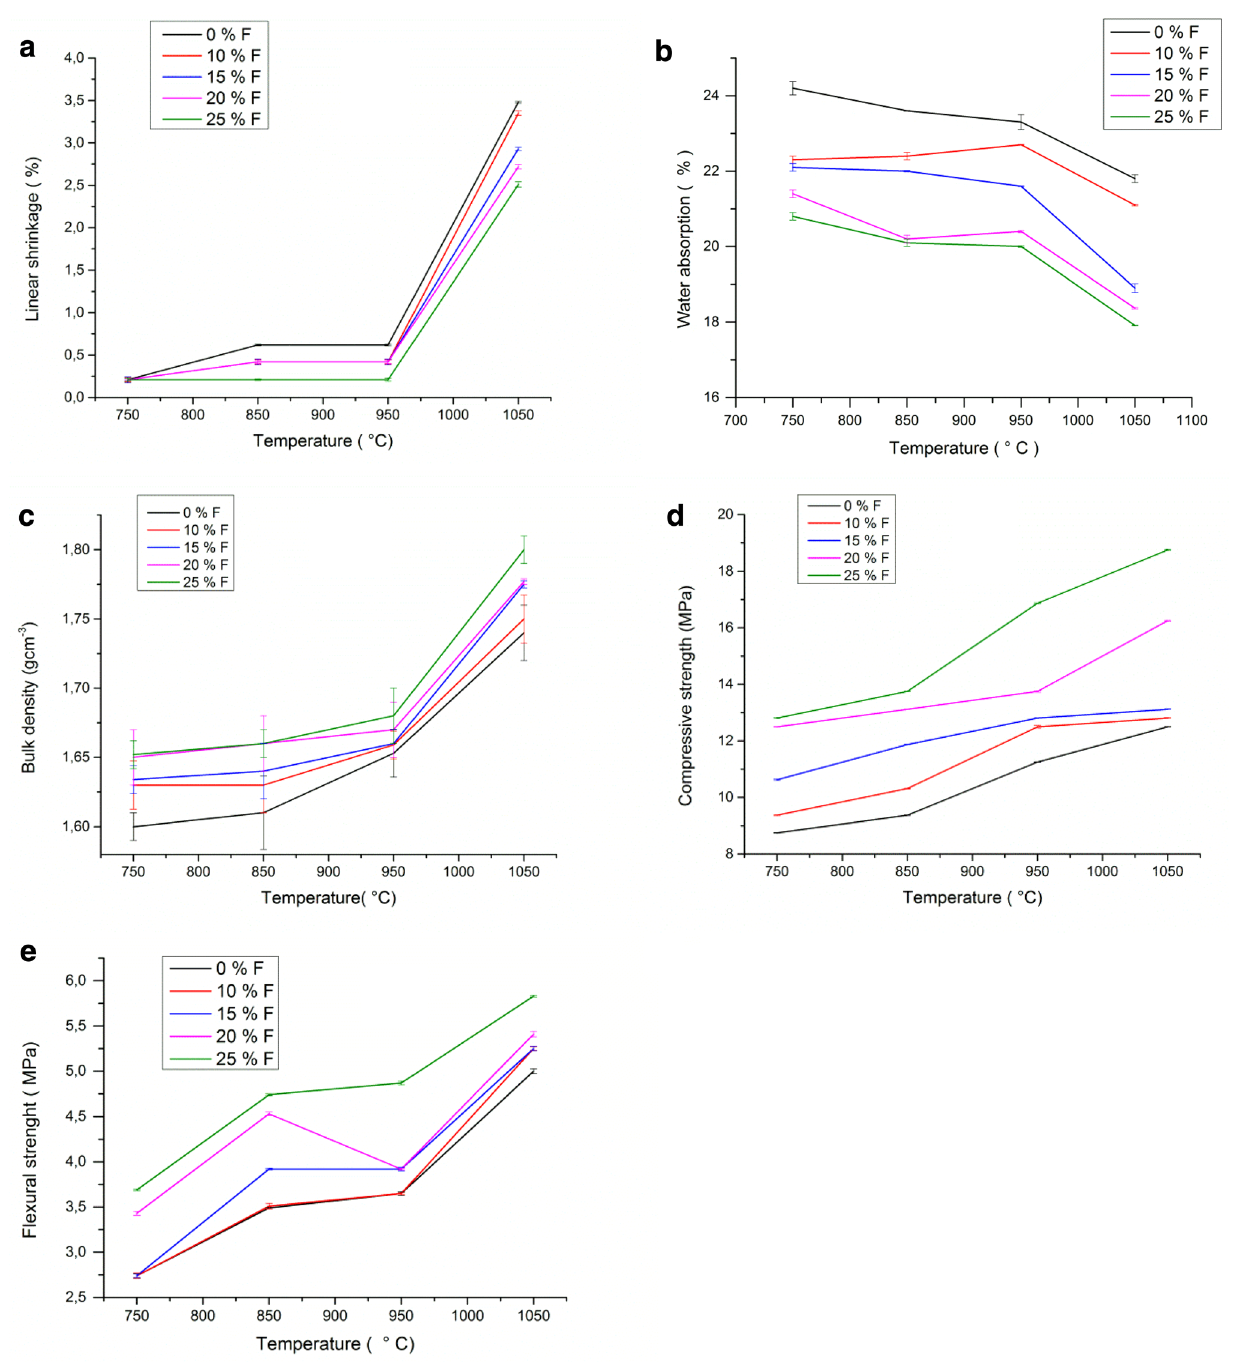
Fig. 6 Evolution of firing properties with sintering temperature and proportion of feldspar a linear shrinkage, b water absorption, c bulk density, d compressive strength, e flexural